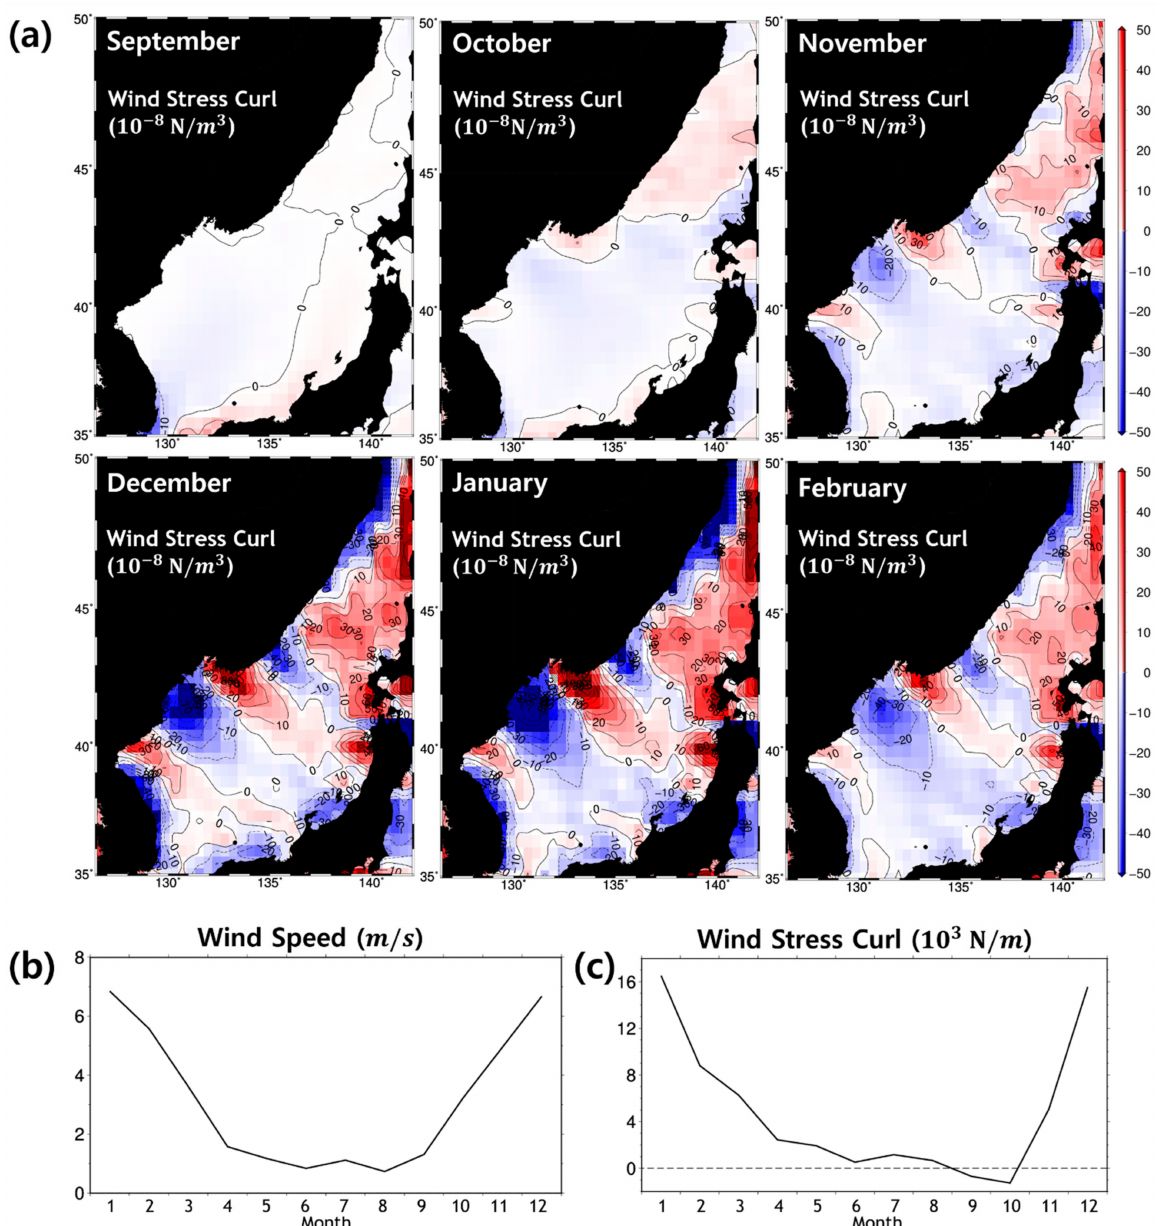
Figure 4. ( a ) Horizontal distributions of climatological monthly mean wind stress curl (in 10 − 8 N/m 3 ) in September– February averaged from 1993 through 2017 from Cross-Calibrated Multi-Platform (CCMP). Blue (red)-colored regions with dashed (solid) lines indicate the negative (positive) wind stress curl. Time series of ( b ) spatial mean wind speed and ( c ) wind stress curl integrated over the NES. Unlike wind speed, the wind stress curl integrated over the NES is the lowest in October, when it has a negative